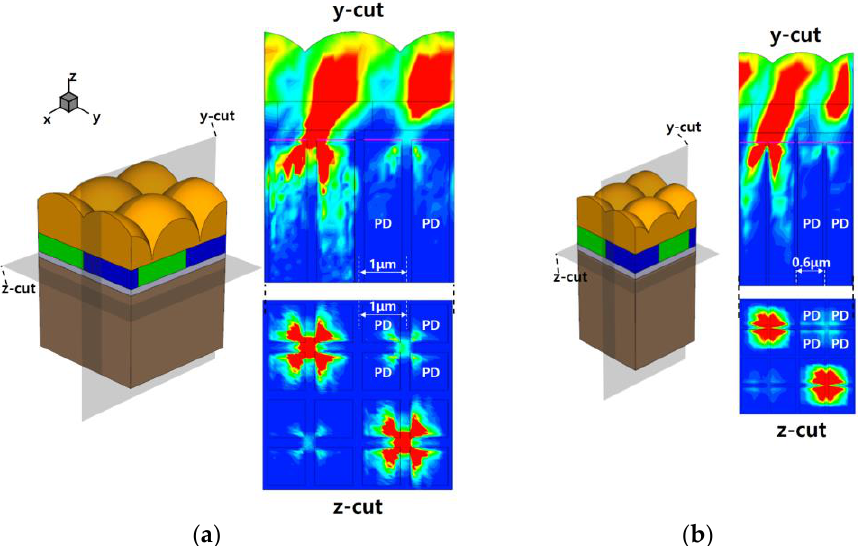
Figure 7. The simulated 3D structure pixel and beam profile of 2 × 2 ML pixel having pixel pitch of ( a ) 1.0 and ( b ) 0.6 μ m at CRA 35°.